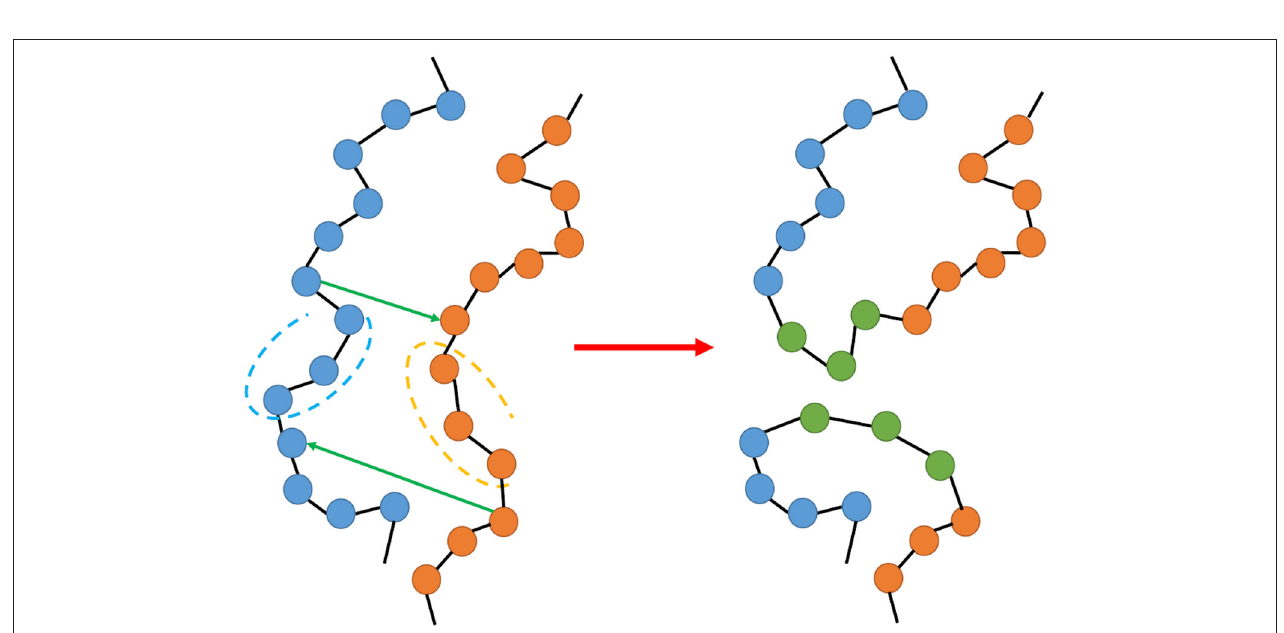
FIGURE 4 | Schematic illustration of the end-bridging Monte Carlo move for polymer simulations in continuous space.